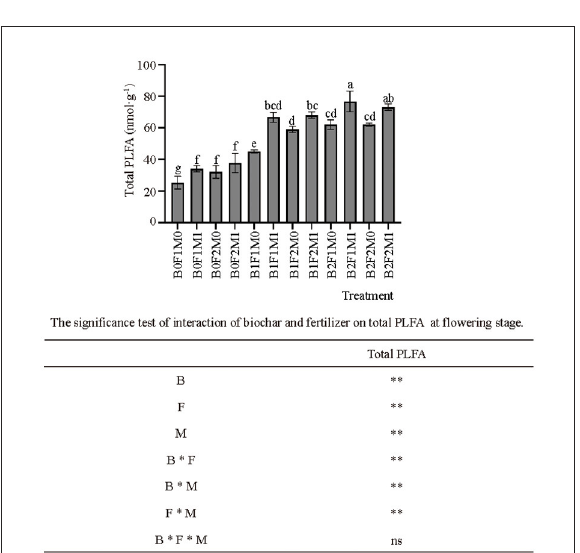
FIGURE5 Effects of biochar, inorganic fertilizer and organic fertilizer on soil PLFA at flowering stage. Bars followed by the same letter are not significantly different according to LSD-test ( P ≤ 0.05). Bars represent standard errors of the means. ** Significant difference at p = 0.01 and ns indicates no significant difference.